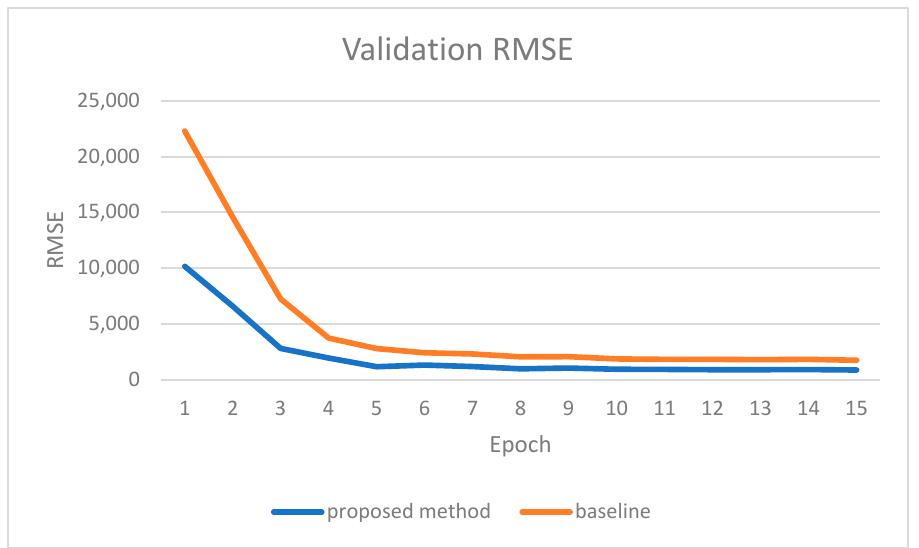
Figure 13. Validation RMSE for each epoch for both the proposed method and the baseline.